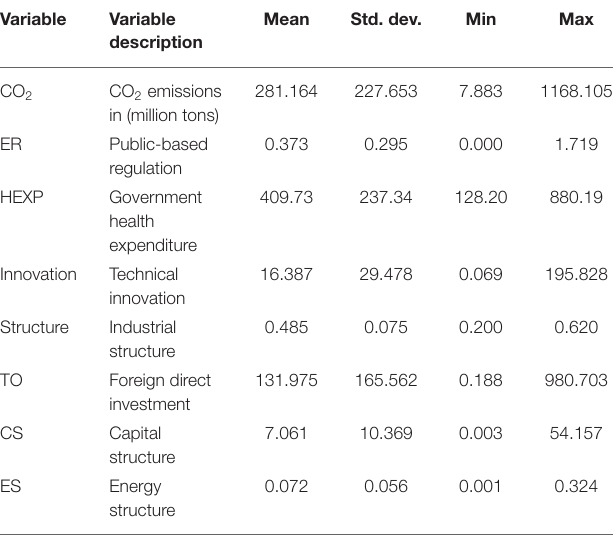
TABLE 1 | Descriptive statics. TABLE 2 | Results of CD and LM test.